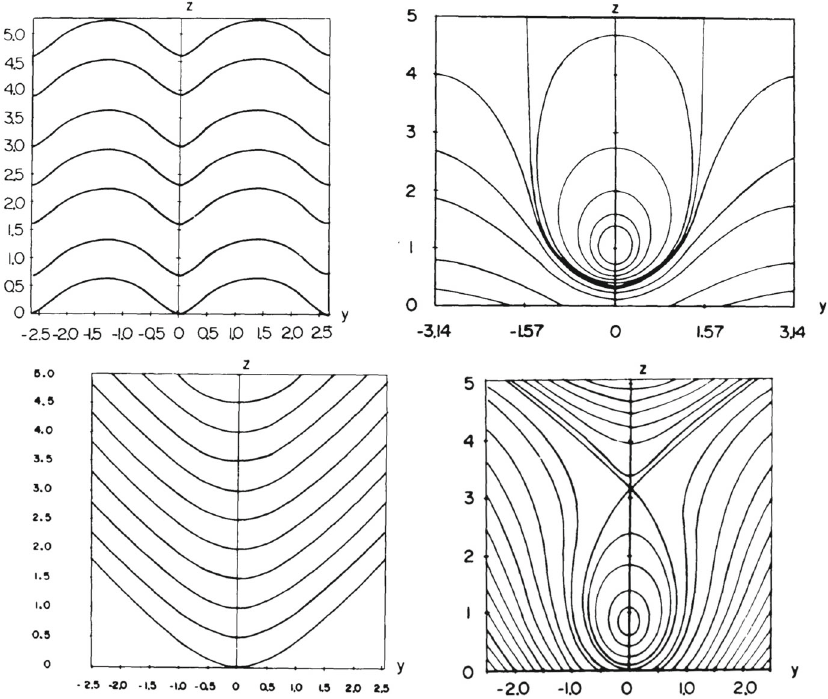
Fig. 41 Magnetic field configuration of the two-dimensional quiescent prominence models whose stability was analysed by Galindo Trejo (1987). Top left: Menzel (1951) model. Top right: Dungey (1953) model. Bottom left: Kippenhahn and Schlüter (1957) model. Bottom right: Lerche and Low (1980) model. These panels do not include all configurations inspected by Galindo Trejo